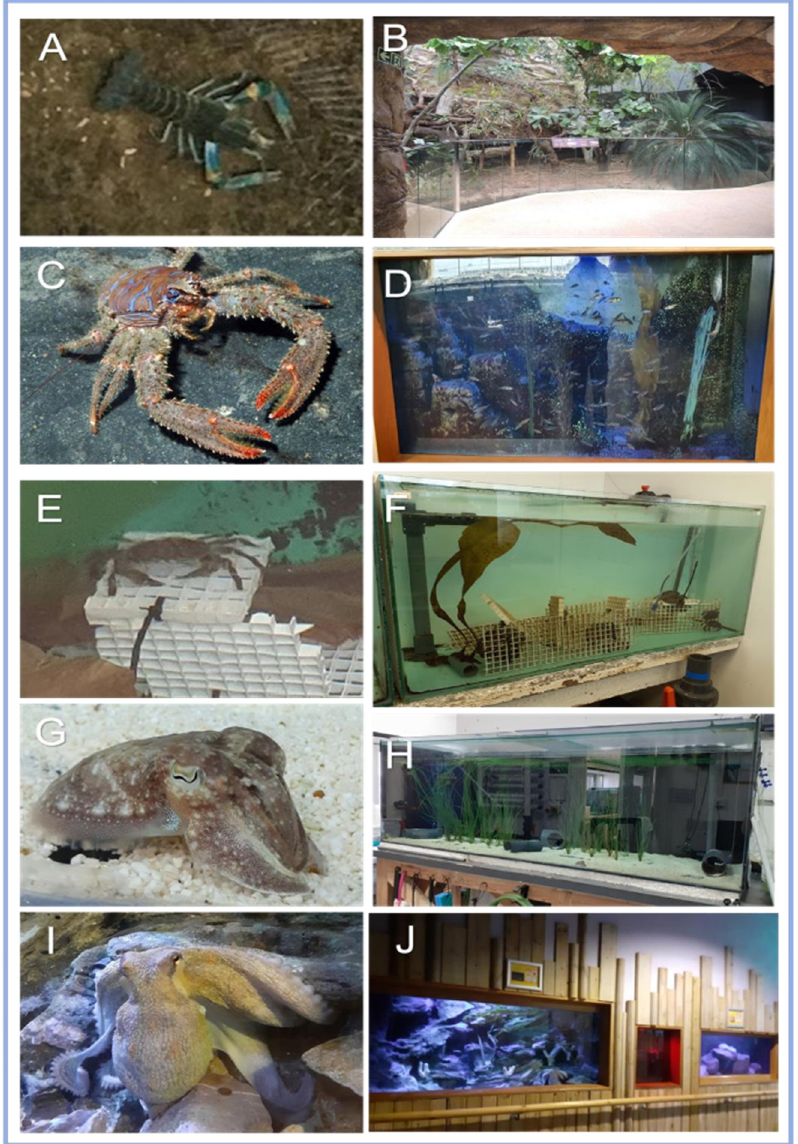
Figure 1. Study subjects. ( A ) Red-clawed crayfish Cherax quadricarinatus , housed in ( B ) Marwell Zoo’s tropical house. ( C ) NMA’s squat -lobster Galathea strigosa housed in ( D ) Plymouth Sound 6 tank (PS-6). ( E ) NMA’s shore-crab Carcinus maenas , initially housed in Temperate Quarantine (TQ) and moved to ( F ) during the trial period. ( G ) NMA’s cuttlefish Sepia officinalis housed in ( H ) PS-3 with two male cuttlefish and NMA’s ( I ) common octopus Octopus vulgaris , had access to three tanks interconnected by tubes ( J ). ( Photos provided by NMA staff, 2021